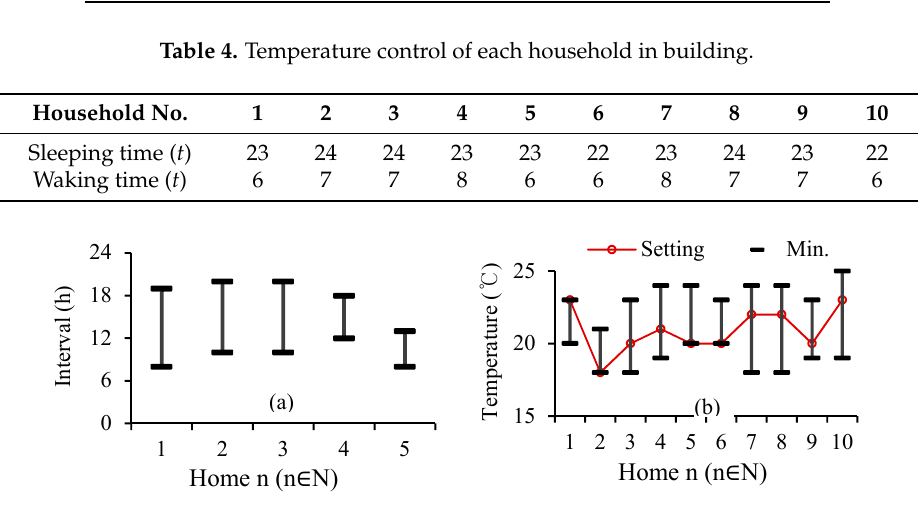
Table 2. Battery energy storage system (BESS) and thermal energy storage system (TESS) parameters.